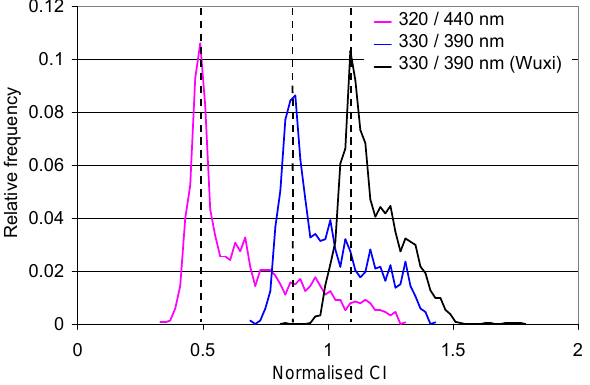
Figure 4. Frequency distribution of the normalised CI for SZA < 60 ◦ (for bins of 0.02). The blue and magenta curves repre- sent the results for Cabauw (1527 measurements); the black curve represents the results for Wuxi (2440